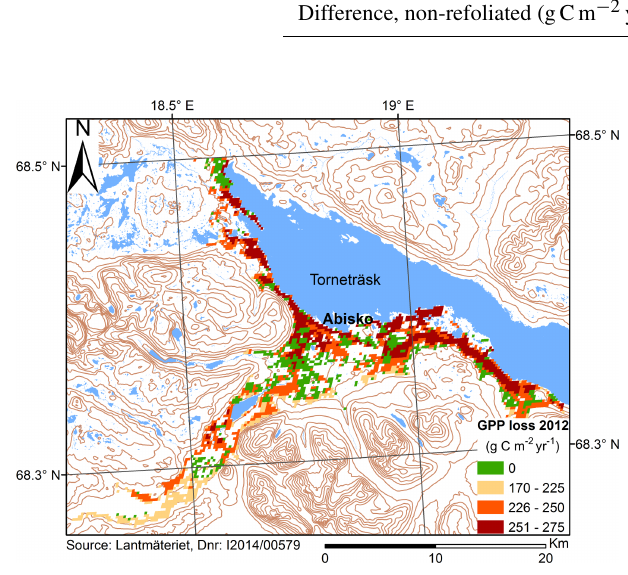
Figure 9. Reduction in annual GPP (gCm − 2 yr − 1 ) due to the out- break of autumnal moth and winter moth in 2012 computed with a LUE model also for defoliation (Method 2). One standard deviation of the GPP losses is estimated to 35% of the given values. Areas with only the background map have a canopy cover less than 50% or are outside the study area shown in Fig. 1. The reference sys- tem is SWEREF99 TM and latitude and longitude are in